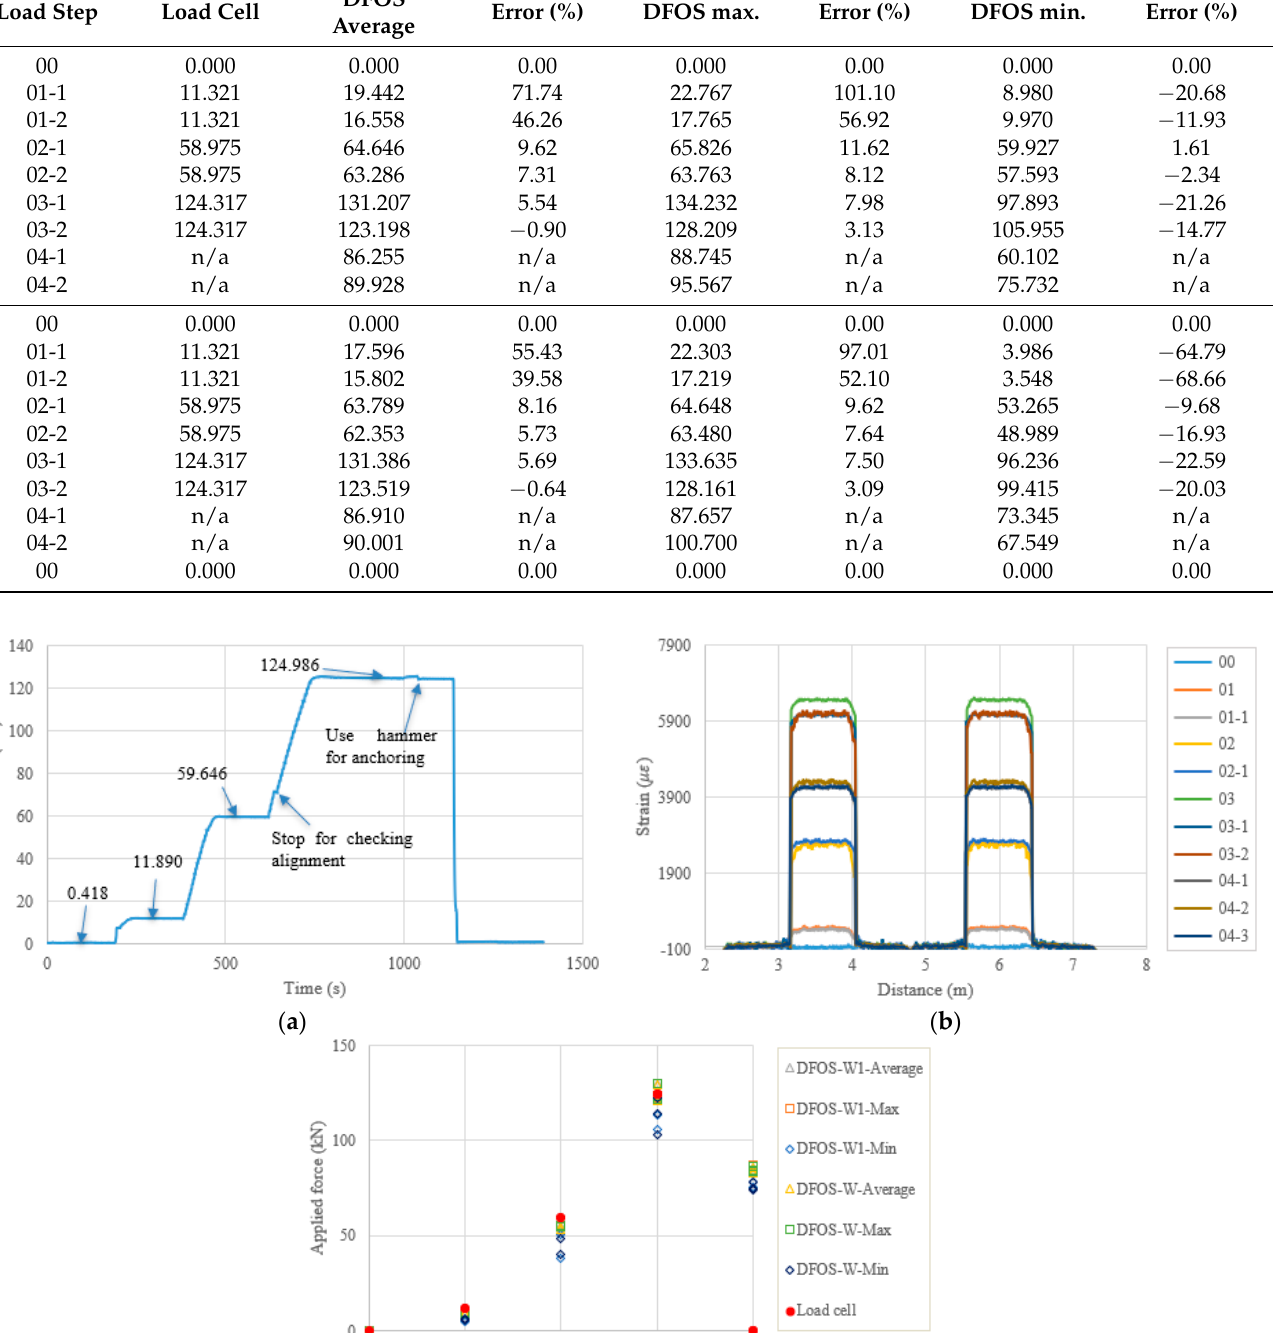
Table 5. Prestressing force monitored by load cell and DFOS for PC5 (unit: kN).